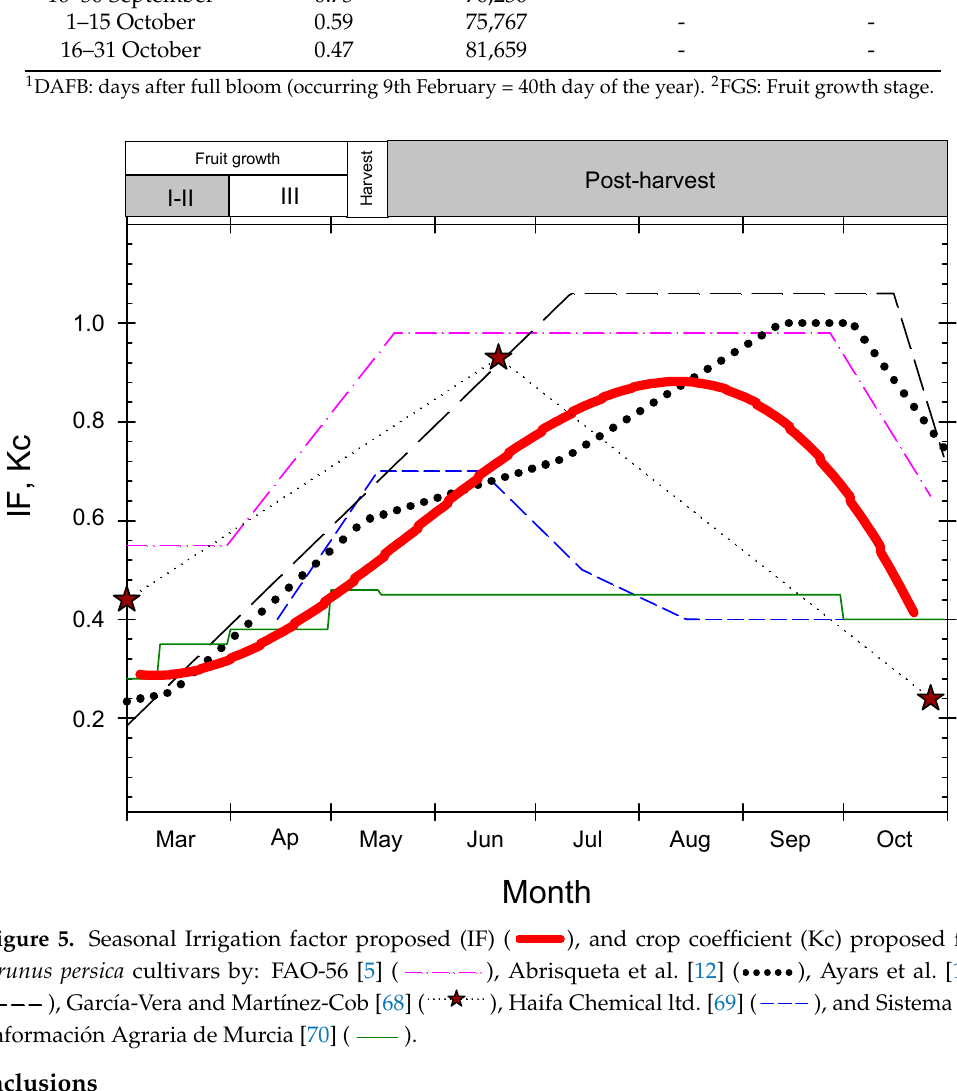
), and crop coefficient (Kc) proposed for